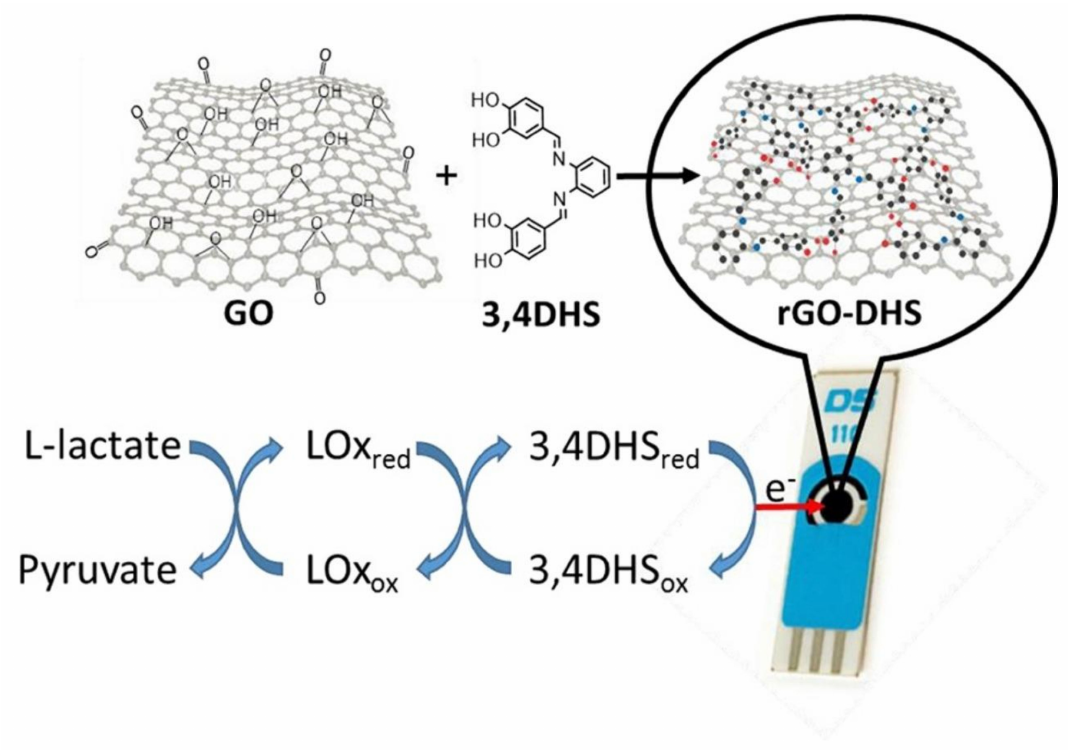
Figure 27. Scheme of the biosensing platform. (Reproduced from [558] with permission. Copyright 2015, Elsevier, Amsterdam, The